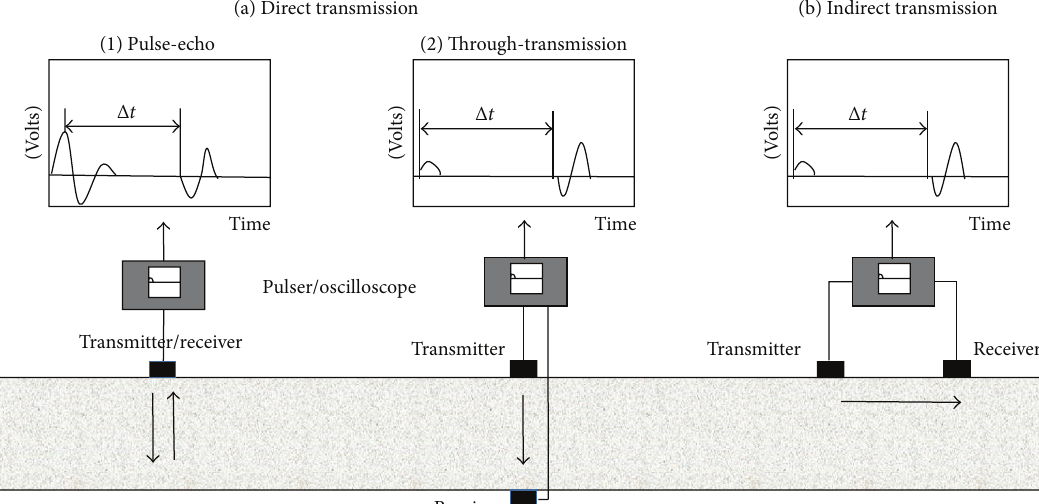
Figure 2: Schematic of ultrasonic direct and indirect transmission method